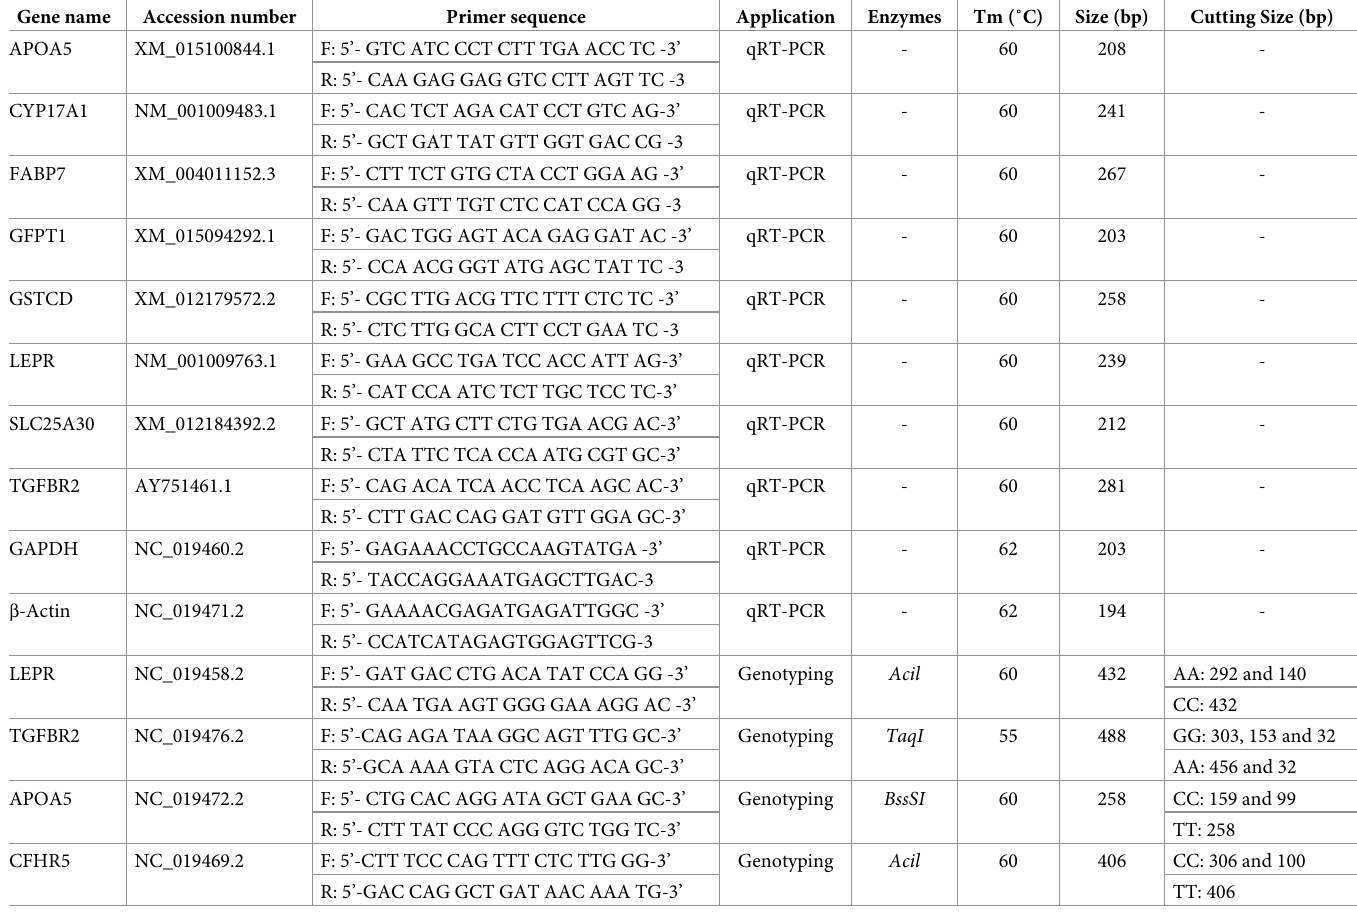
Table 4. GenBank accession numbers and primer sequences for qRT-PCR and